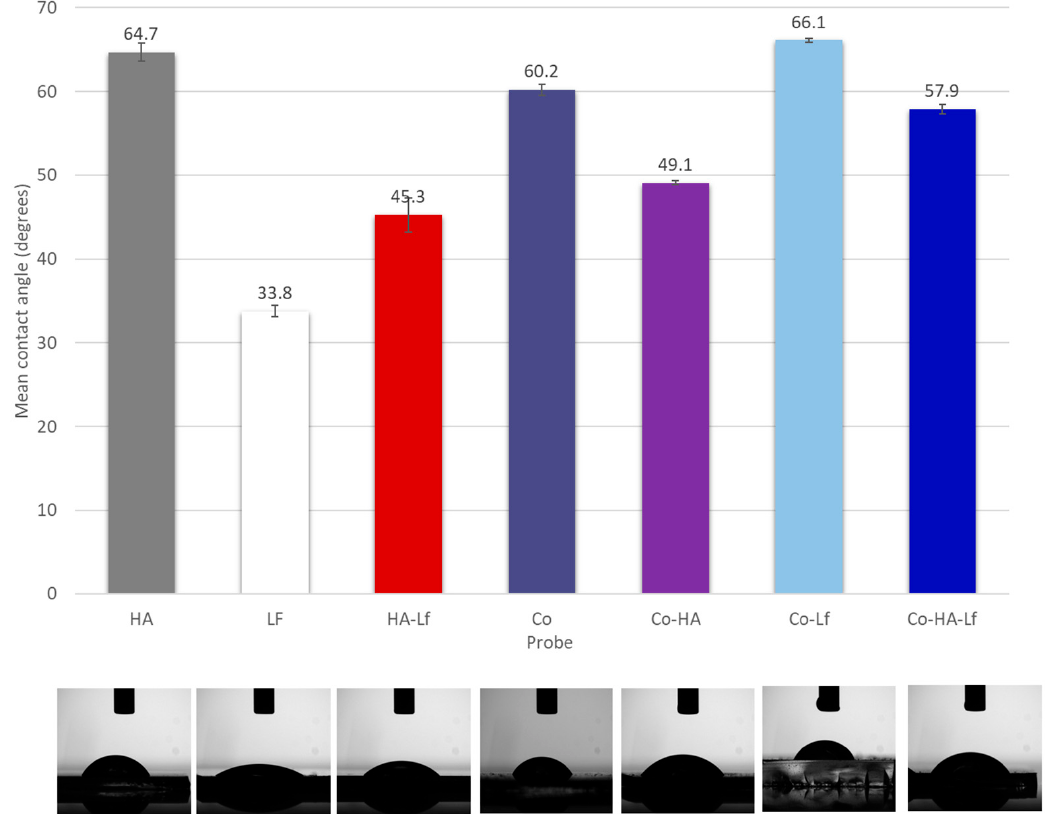
Figure 4. Histogram of contact angle measurements using water as a wetting agent.